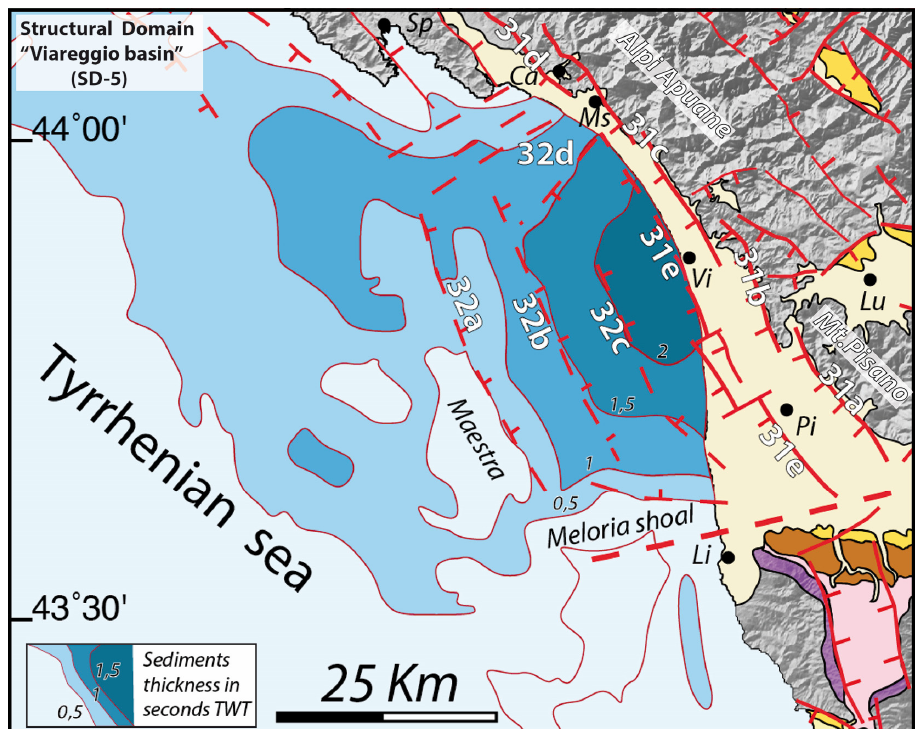
Figure 9. Main fault systems and geology in structural domain SD5 (Viareggio basin). Fault identification numbers are as reported in Table S1. Offshore sediment thickness after [30,31]. Ca: Carrara; Lu: Lucca; Li: Livorno; Ms: Massa; Pi: Pisa; Sp: La Spezia; Vi: Viareggio.